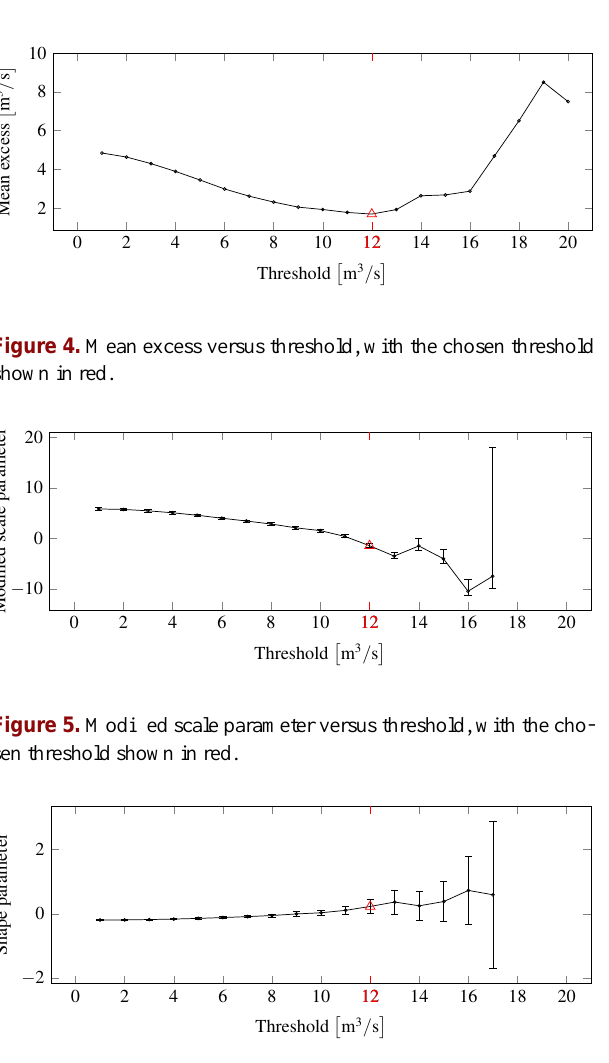
Figure 6. Shape parameter versus threshold, with the chosen threshold shown in